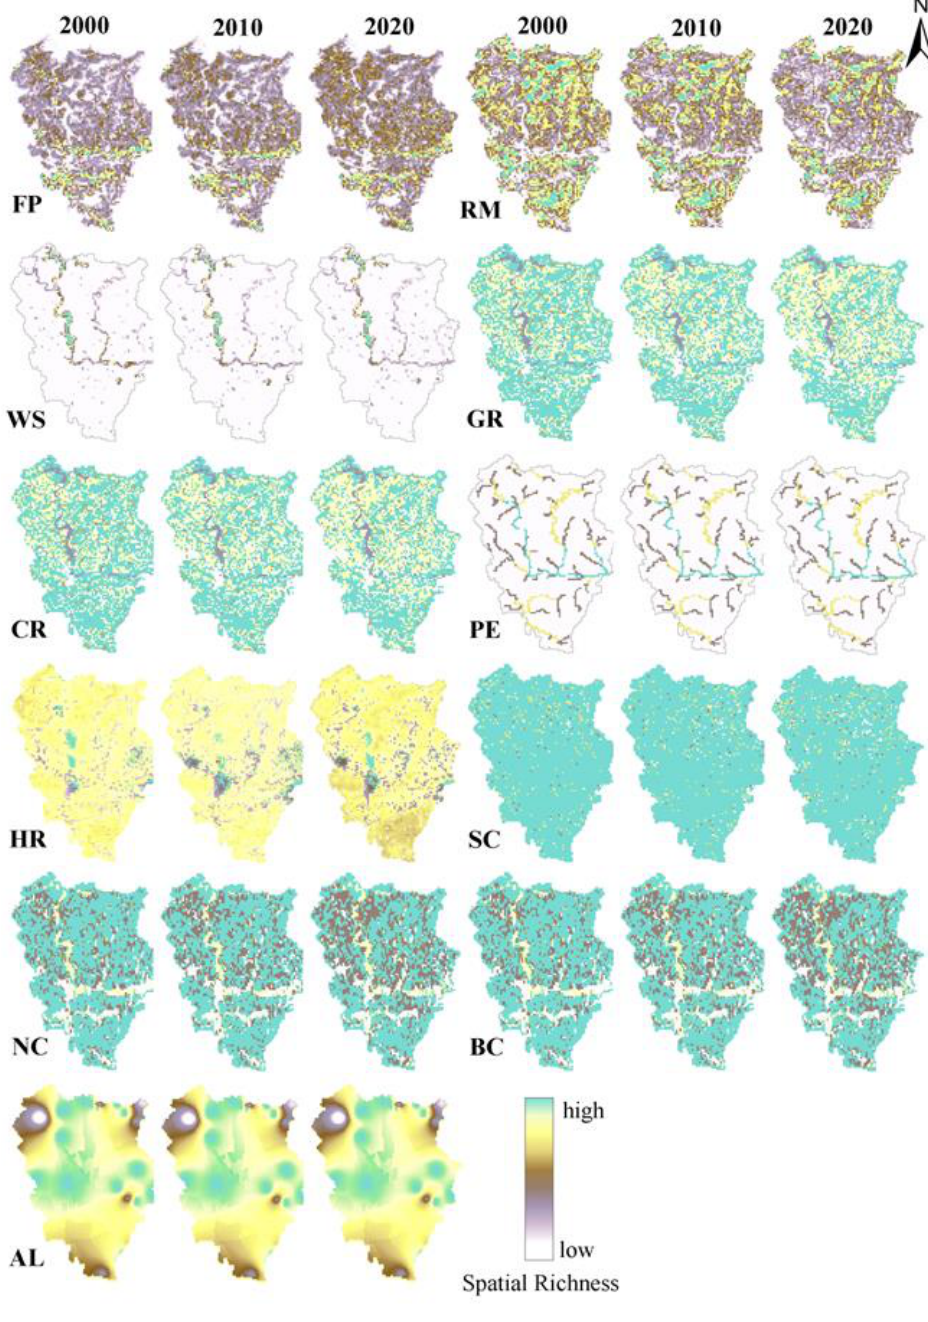
Figure 8. Spatial richness of ESs.